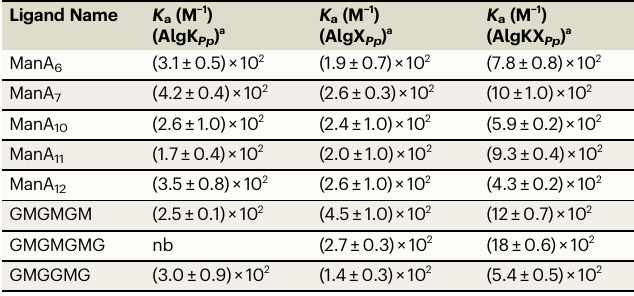
Table 1 | Apparent association constants ( K a ) for AlgK Pp , AlgX Pp , and AlgKX Pp for short polymannuronic and polymannuronic-guluronic oligosaccharides as determined by direct ESI-MS in 200 mM aqueous ammonium acetate solution at pH 7 and 25 °C. Source data are provided as a Source Data fi